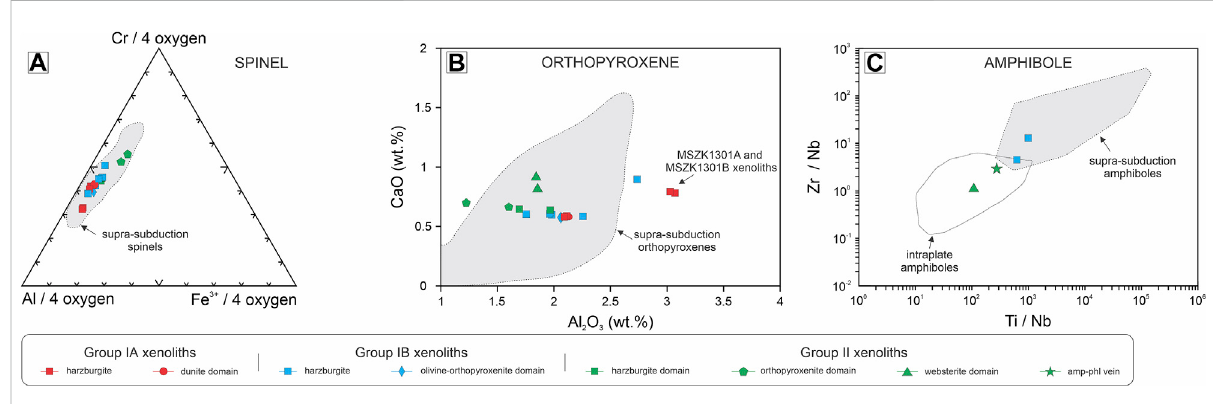
FIGURE 8 Relationship between (A) Al-Cr-Fe 3+ in spinel (supra-subduction spinels are based on Arai et al., 2004); (B) Al 2 O 3 vs. CaO in orthopyroxene (supra-subduction orthopyroxenes are based on Arai and Ishimaru, 2008); (C) Ti/Nb vs. Zr/Nb in amphibole (supra-subduction and intraplate amphiboles are based on Coltorti et al., 2007) for studied MSZK